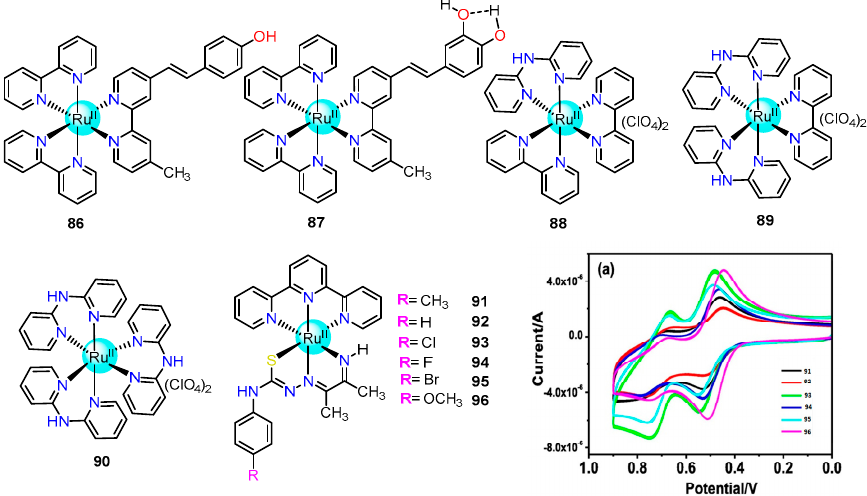
Figure 14. Structures of 2,2’-dipyridylamine − based Ru(II) complexes 88 – 96 and ( a ) cyclic voltammograms of 91 – 96, recorded in acetonitrile solution with Ag/AgCl/KCl(std.) electrode. [Adapted from reference [112]; © 2023 Elsevier B.V. All rights reserved] .